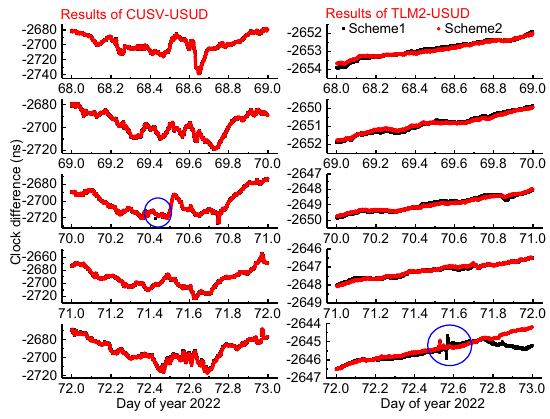
Fig. 13 Clock difference of CUSV-USUD and TLM2-USUD from BDS-3/ GPS PPP in Scheme 1 and Scheme